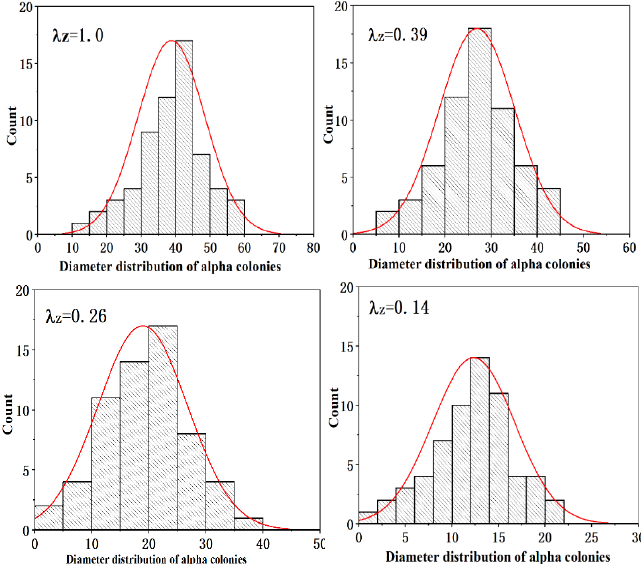
Figure 8. Changes in the distribution of the size of the alpha colonies during thermal deformation. However, as shown in Figure 9, broken TiB fibers were observed in the composite after thermal deformation, which decreased the aspect ratio of the TiB fibers. Figure 10 shows the changes in the aspect ratio of the TiB fibers after deformation to different ex ‐ tents. The results indicate that with an increase in the extent of deformation, breakage of the TiB fibers became severe, and even TiB fibers with a higher aspect ratio were broken several times by thermomechanical processing.